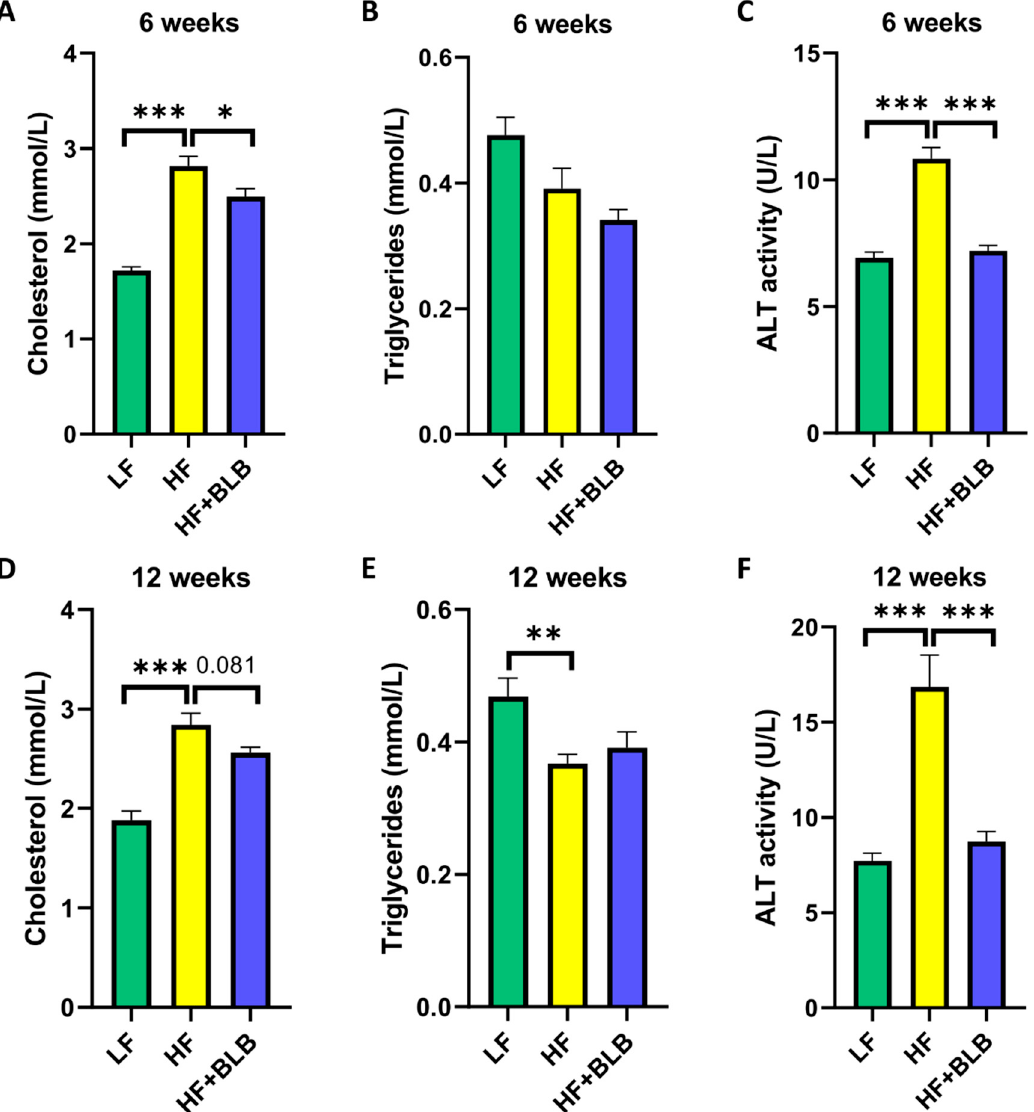
Figure 3. Fasting cholesterol, triglyceride levels, and alanine aminotransferase (ALT) activity. The mice received a low-fat diet (LF, 10% of energy from fat), a high-fat diet (HF, 46% of energy from fat) or a bilberry-supplemented high-fat diet (HF+BLB, 20% air-dried bilberry powder) for six ( A – C ) or twelve ( D – F ) weeks. The fasting cholesterol levels ( A , D ), triglyceride levels ( B , E ), and ALT activity ( C , F ) were measured from serum and analyzed with a one-way ANOVA and a Bonferroni multiple comparisons test. The statistically significant differences from the HF group are marked with * p < 0.05, ** p < 0.01, and *** p < 0.001. The results are expressed as mmol/L for cholesterol and triglycerides and U/L for ALT activity; values represent mean + SEM; n = 12 mice in each group. Circulating alanine aminotransferase (ALT) is widely used as a marker of liver injury and inflammation. After six weeks, the ALT activity in the LF group was 6.93 ± 0.22 U/L and that in the HF group 10.8 ± 0.44 U/L ( p < 0.001). The ALT activity was 7.21 ± 0.21 U/L